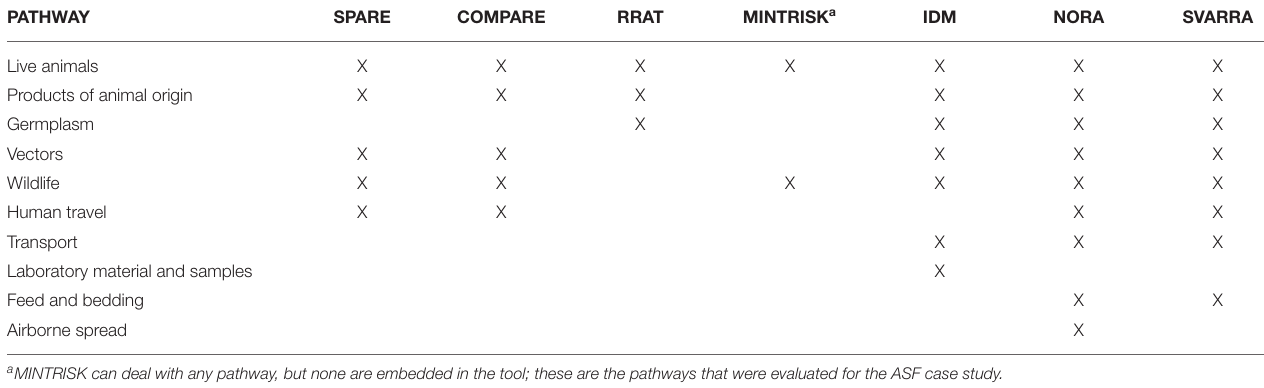
TABLE 2 | Introduction pathways embedded in each of the generic RA tools.